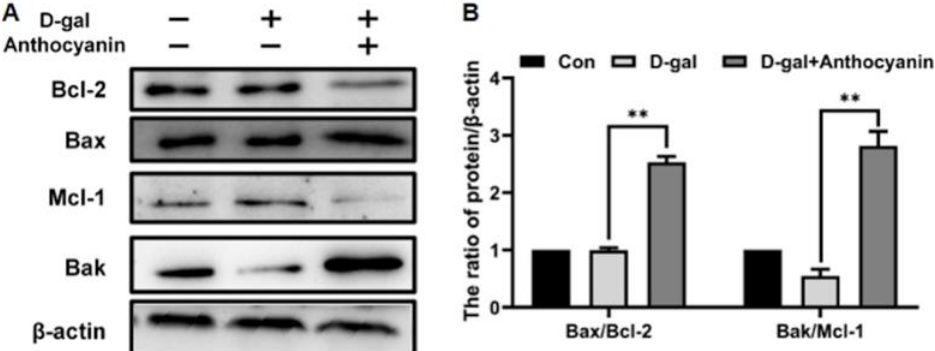
Figure 5. Anthocyanin inhibited the PI3K/Akt/mTOR signaling pathway of senescent cells. ( A , B ) Cells were treated with 40 mM D-galactose alone or in combination with 80 μg/mL anthocyanin for 72 h. The expression of Bcl-2 family proteins was measured using western blot. Data are presented as mean ± SD, n = 3. ** p < 0.01.